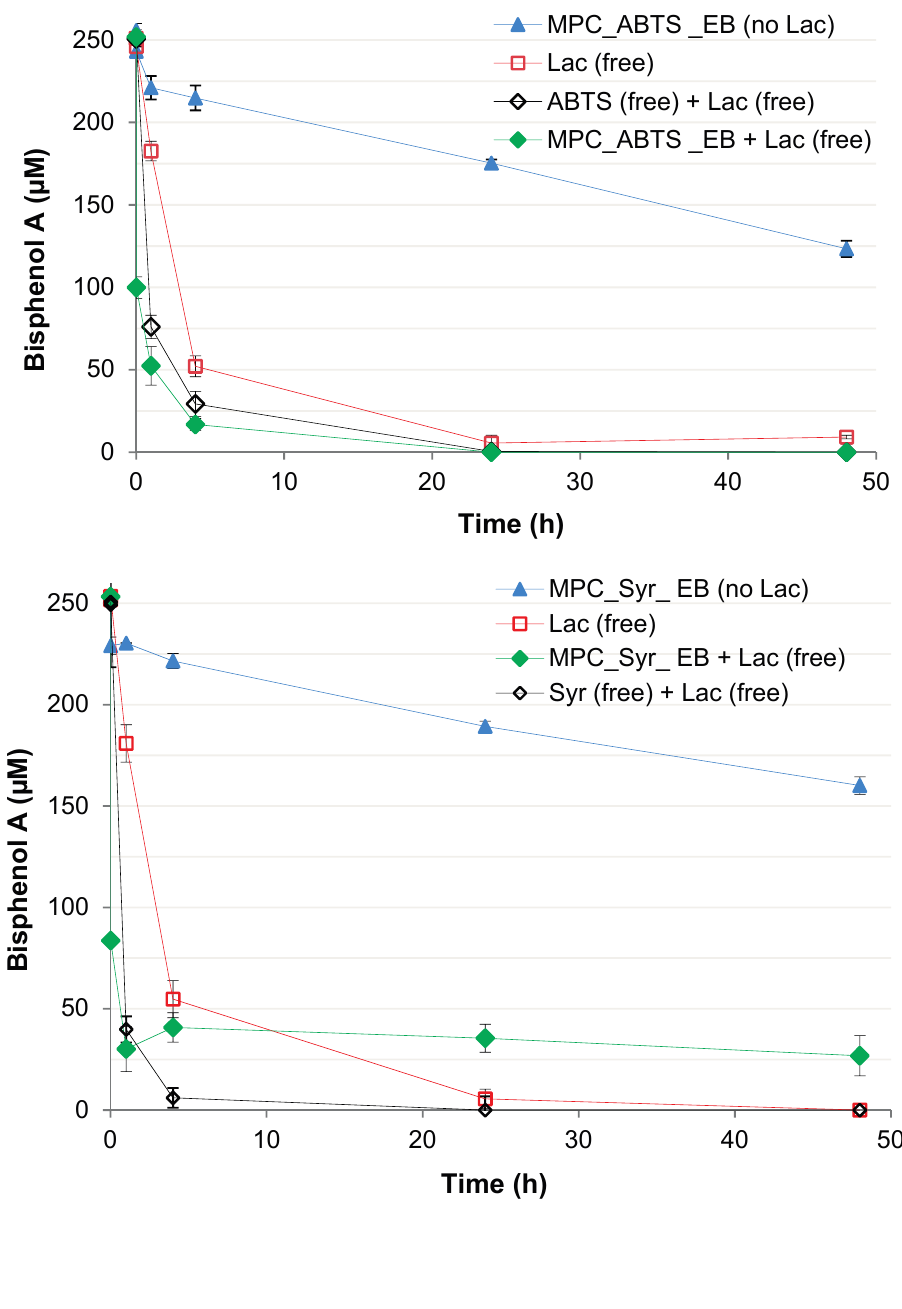
Figure 8. Time courses of BPA concentrations in degradation experiments employing freely suspended laccase (Lac) together with cryogels containing E-Beam-immobilized ABTS (MPC_ABTS_EB, upper figure) and Syr (MPC_Syr_EB, lower